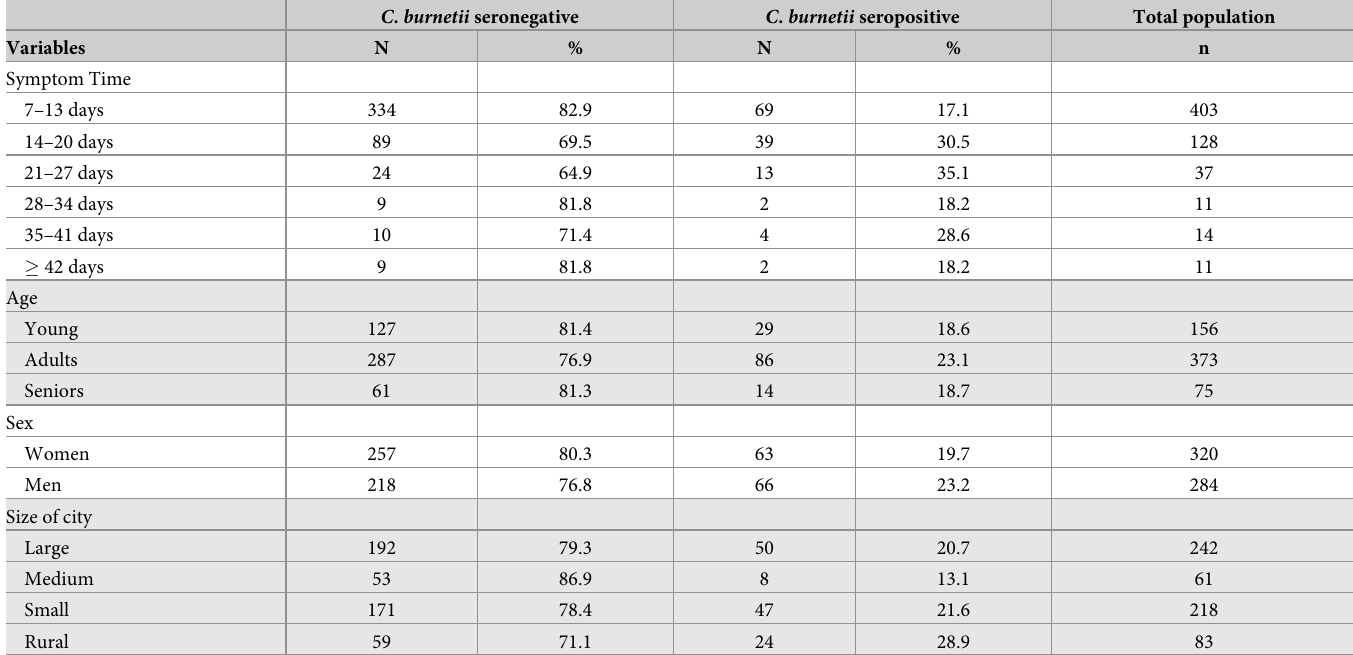
Table 4. Clinical and sociodemographic characteristics of febrile patients in S ã o Paulo state, Brazil (2014–2017) and their respective seropositivities for Q